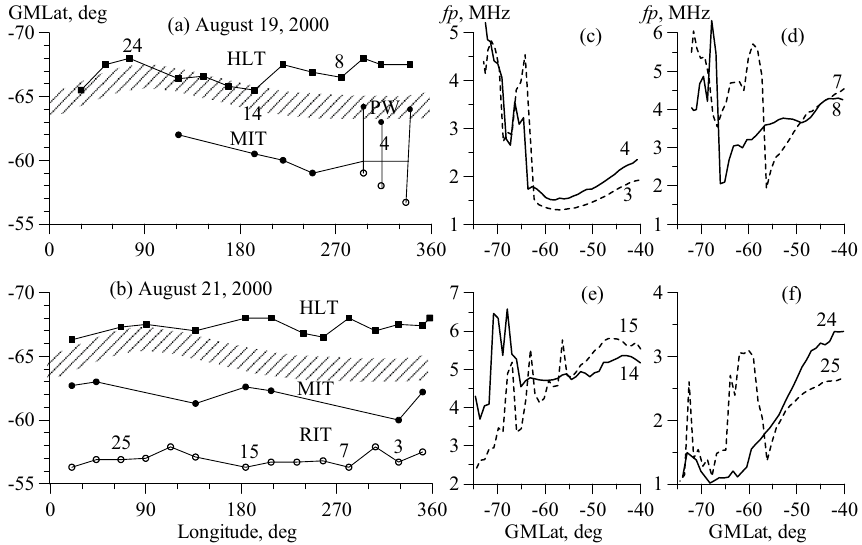
Figure 3. Longitudinal variations in the position of HLT (squares) and MIT (dots) on August 19 2000 ( a ) and August 21, 2000 ( b ). Empty circles show the positions of the fp minima (top) and RIT (bottom). The shaded latitude belts show the diffuse auroral precipitation in zone I. On the right are the latitudinal profiles of fp for the paths marked in the Figure on the left (solid curves for August 19, dashed curves for August